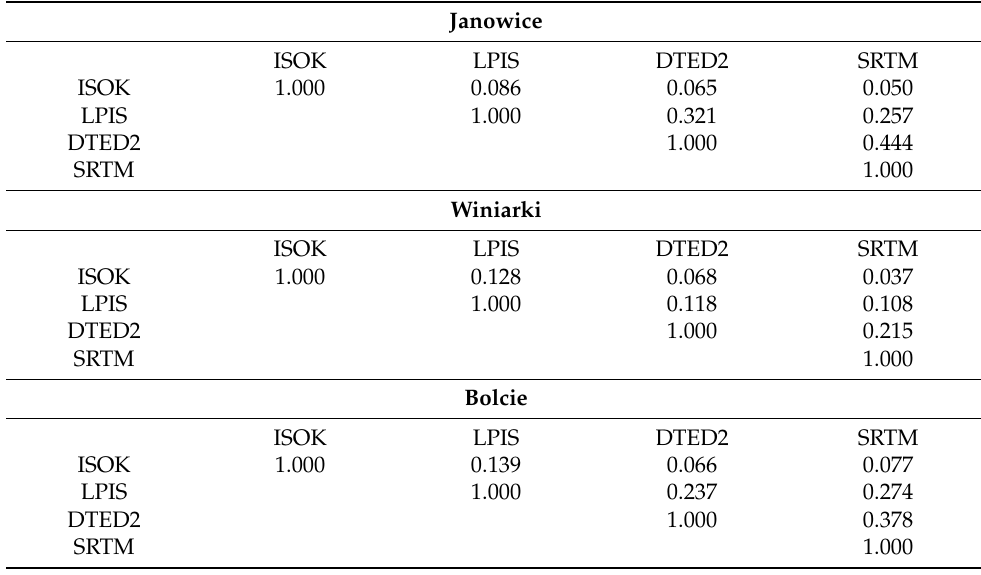
Table 12. Summary of the Pearson correlation coefficients for the total LS factor values calculated on the basis of 4 DTM sources in the 3 research